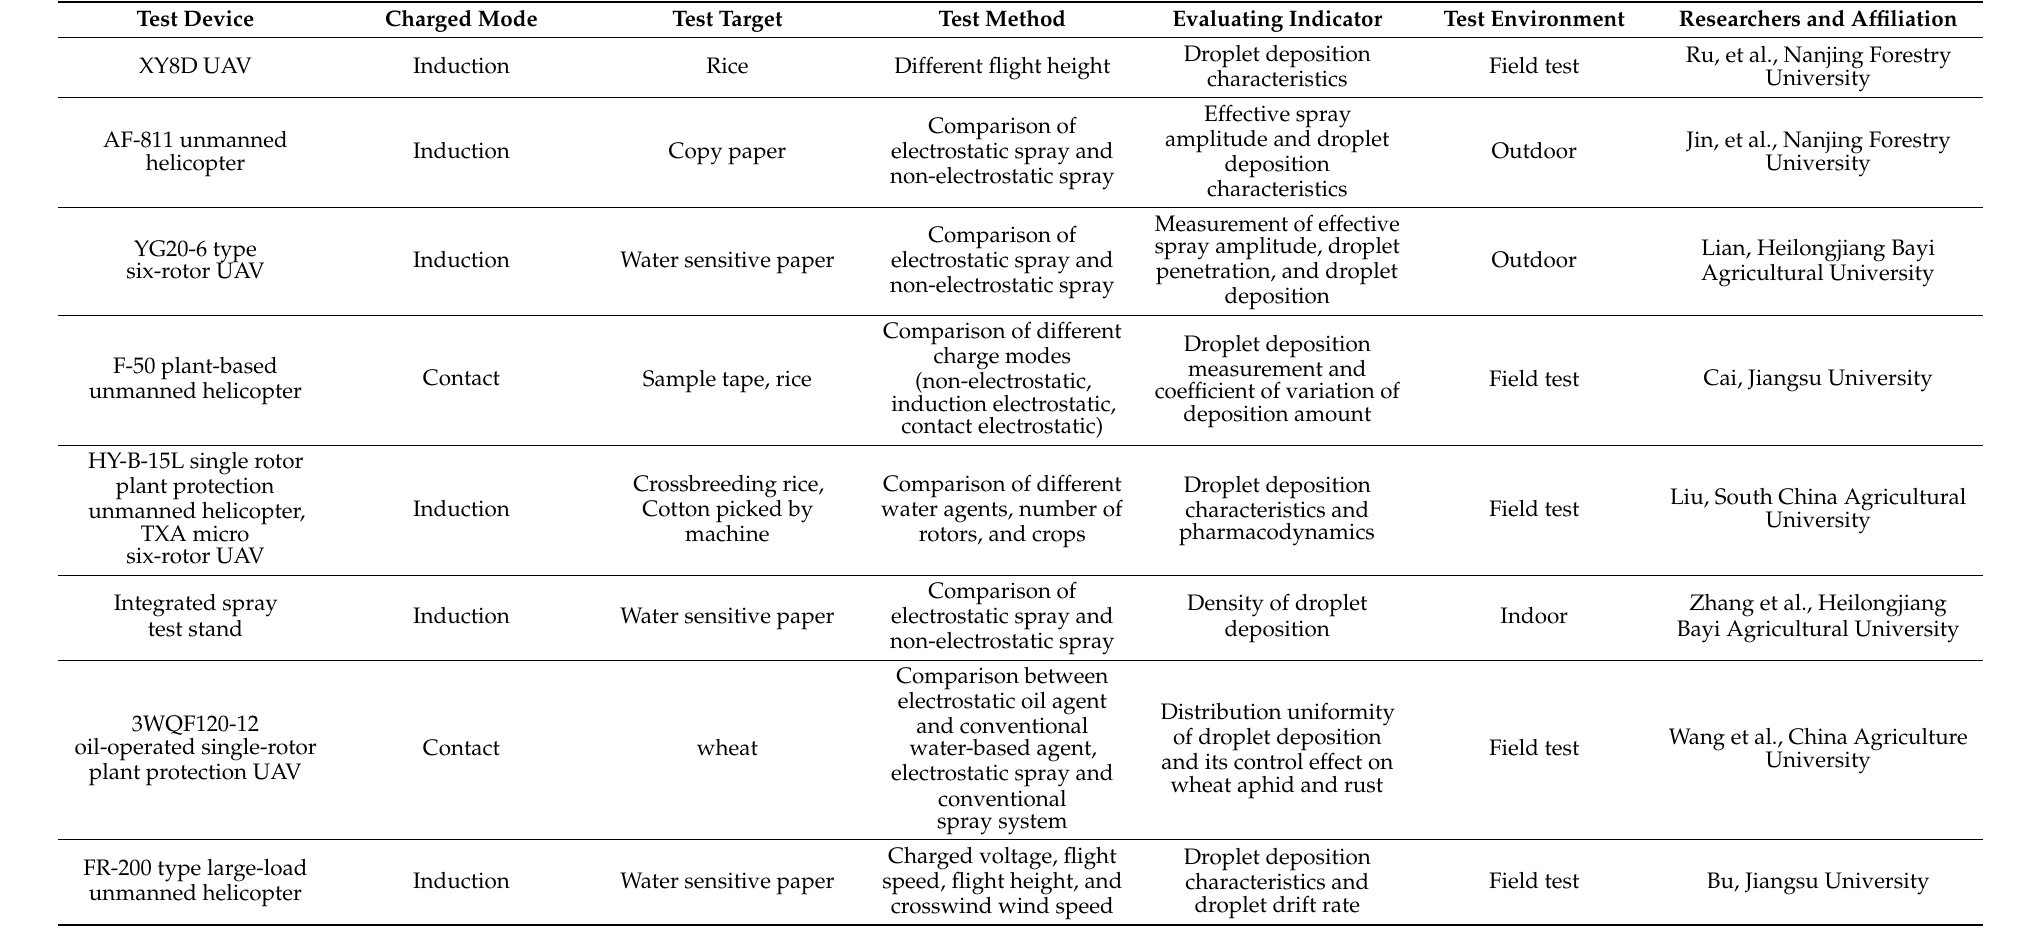
Table 1. Study on UAV-based Electrostatic Spray